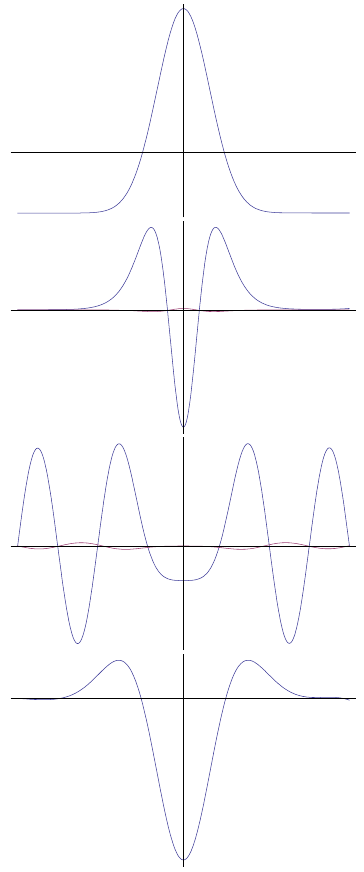
Fig. 5. Representative solutions of equations (5) and (6). Top panel: Fig. 5. Top panel: Functional form of (cid:15) 0 − N(x) corresponding Functional form of ǫ 0 − N ( x ) corresponding to a depleted caviton. to a depleted caviton. Second panel: Solution for the case k 2 k = 0 Second panel: Solution for the case k 2 = 0 and λ 2 > 0 . Third k and λ 2 > 0. Third panel: Solution for the case k 2 k = 0 and λ 2 < 0 panel: Solution for the case k 2 = 0 and λ 2 < 0 Bottom panel: k Bottom panel: Solution for the case k 2 k > 0 and λ 2 < 0. Dirichlet Solution for the case k 2 > 0 and λ 2 < 0 . Dirichlet boundary k boundary conditions are applied at either end of the conditions are applied at either end of the abscissa.